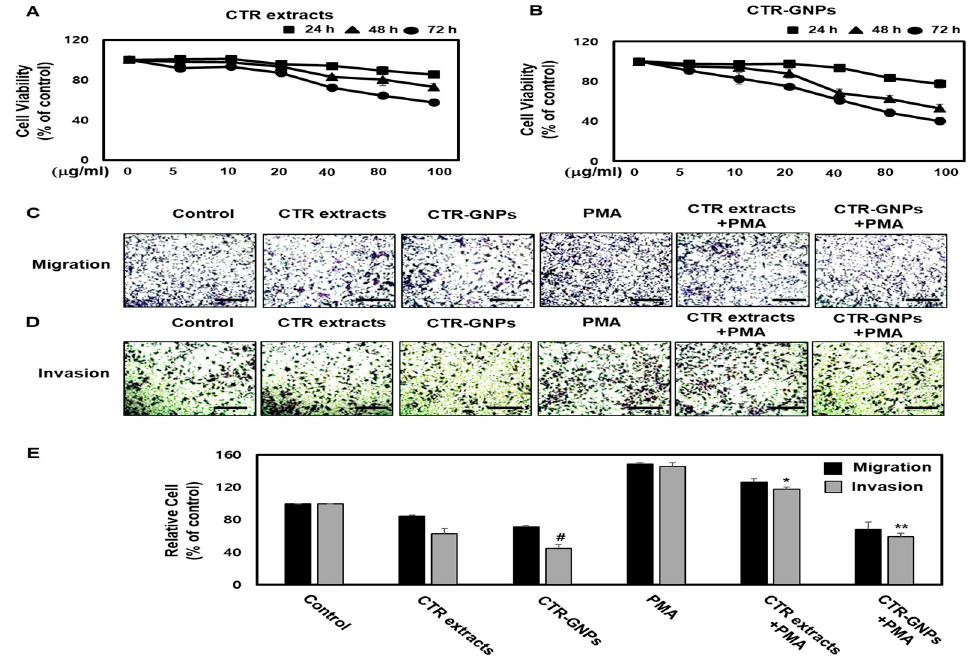
Figure 3. CTR-GNPs attenuate the migration and invasion in basal and phorbol 12-myristate 13-acetate (PMA)-stimulated human U87 glioblastoma cells. ( A , B ) Cell viability was detected by cell counting kit-8 (CCK-8) assay. ( C ) Cell migration was detected by the CytoSelect ™ 24-Well Cell Migration assay kit (Scale bar, 200 µ M). ( D ) Cell invasion was detected by the CytoSelect ™ 24-Well Cell invasion assay kit (Scale bar, 200 µ M). ( E ) Quantitative analysis of the percentages of migratory and invasive cells. # p < 0.05 compared to the control group (only distilled-water treatment). * p < 0.05 and ** p < 0.01 compared to the PMA treated group. All data are presented as means ± SEM ( n = 3).